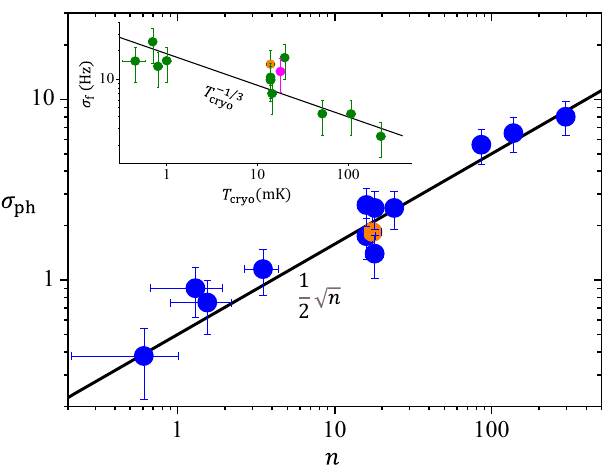
Fig. 3 Frequency and population standard deviations. Main: standard deviation of the phonon population extracted from Fig. 2b as a function of ffiffiffi p n the average population. The black line is a / guide to the eye. Top inset: frequency shift standard deviation calculated over 10 h averaging as a function of cryostat temperature. The line is a power-law fi t. The magenta point is inferred from data taken in the self-oscillating regime; in both graphs, the orange dot is obtained with a measuring input power twice smaller (see text). Error bars correspond to type A uncertainties extracted from the fi tting process (Supplementary Note